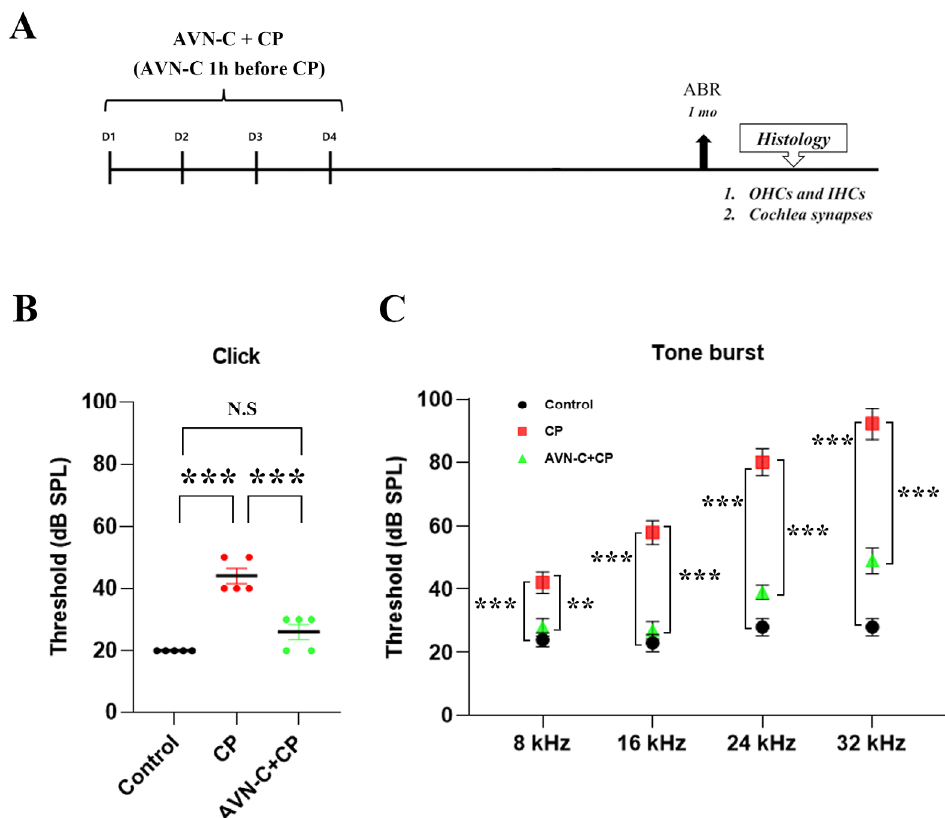
Figure 1. In case of cisplatin-induced ototoxicity, AVN-C improves the auditory brainstem response (ABR). ( A ) For 4 days, AVN-C pretreatment was administered 1 h before cisplatin therapy every day. ABR was performed at 1, 2, and 4 weeks; ( B ) Cisplatin impaired hearing in wild-type mice by causing the threshold shift to increase whereas AVN-C maintained the threshold shift within the normal range (*** p ≤ 0.001). ( C ) Cisplatin-induced elevation of thresholds in wild-type mice at high frequencies (16, 24, and 32 kHz) whereas AVN-C mimicked similar results at 8 and 16 kHz and manifested decreased threshold shifts at 24 and 32 kHz (** p ≤ 0.01 at 8 kHz, *** p ≤ 0.001 at 16, 24, and 32 kHz; AVN-C vs. cisplatin, n = 5). (N.S = not significant).